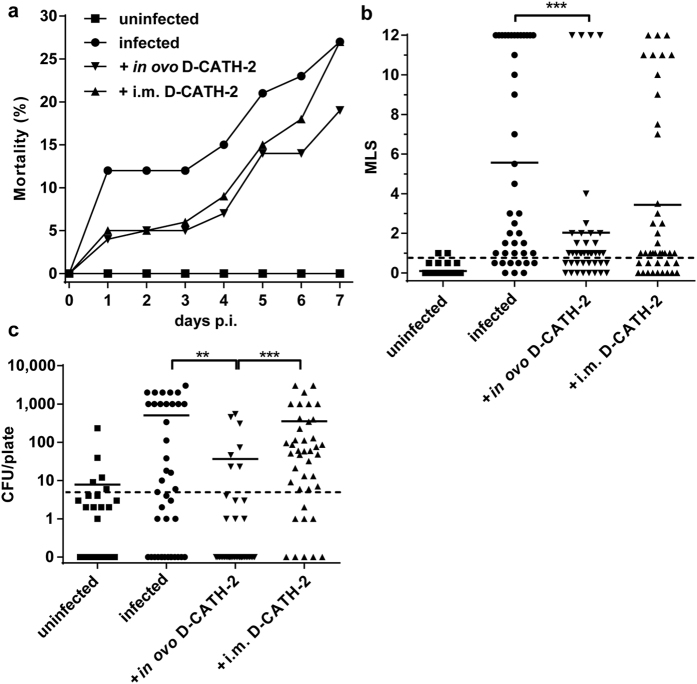
E. coli related mortality (a), morbidity (b) and bacterial counts in air sacs (c) at 7 days post challenge. Chickens were treated in ovo with 1 mg/kg bodyweight D-CATH-2 or i.m. at day of hatch and day 4 with 20 and 2.5 mg/kg bodyweight D-CATH-2. At 7 days post hatch, chickens were inoculated intratracheally with 107 CFU of E. coli 506. Morbidity is represented as Mean Lesion Score, the sum of gross pathology scored in air sacs, liver and pericardium (b). Dotted line indicates MLS = 1, above which animals are considered colibacillosis positive (Table 1). Air sac swabs were plated on MacConkey/Sheep Blood agar plates and colonies were counted after overnight incubation (c). Dotted line indicates CFU = 5, above which animals are considered E. coli positive (Table 2). Mortality data were analyzed by the Kaplan-Meier method, morbidity results and E. coli counts were analyzed by one-way ANOVA with a Games-Howell post-hoc test for non-equal variances. **p < 0.01, ***p < 0.001.